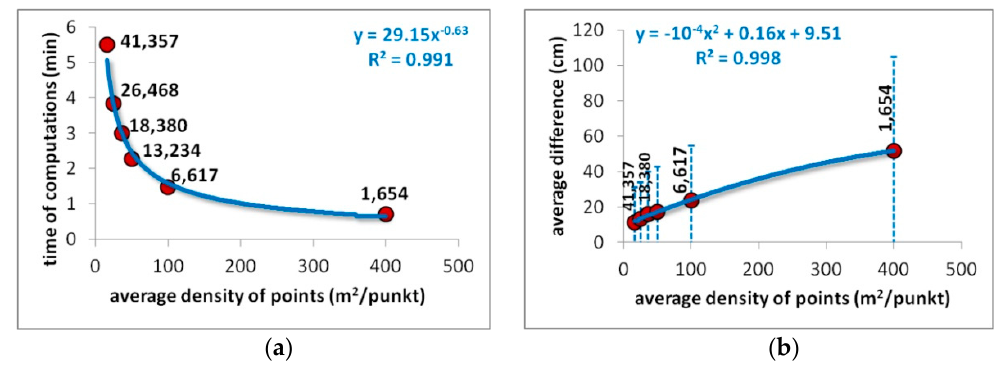
Figure 11. Results of efficiency tests: ( a ) Dependency of computational time on density of points in the third algorithm; ( b ) Dependency of difference between the first and third algorithm on density of points.